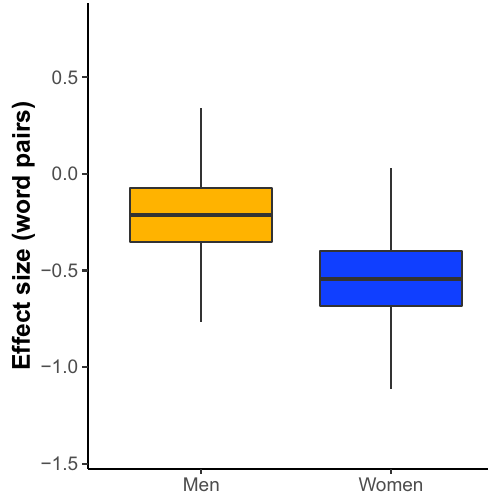
Figure 5. The propensity score matching main effect of self-reported smoking on PAL performance across all ages separately between men and women. We conducted propensity score matching (PSM) analysis matching smokers and non-smokers for various health and lifestyle factors from self-report including: age, race, ethnicity, marital status, handedness, education level, number of daily medications, history of diabetes, seizures, cancer, stroke, hypertension, heart disease, family history of Alzheimer disease, drug abuse, loss of consciousness, and dizziness. The dependent variable was the total number of correct word pairs entered across the three trials of PAL tests (range of 0–36). When collapsed across age, PSM suggested there is no effect of smoking on memory in males (β = − 0.21 (− 0.62 to 0.19, 95% credible interval)) and a negative effect in females (β = − 0.54 ( − 0.93 to −0.14, 95% credible interval)).